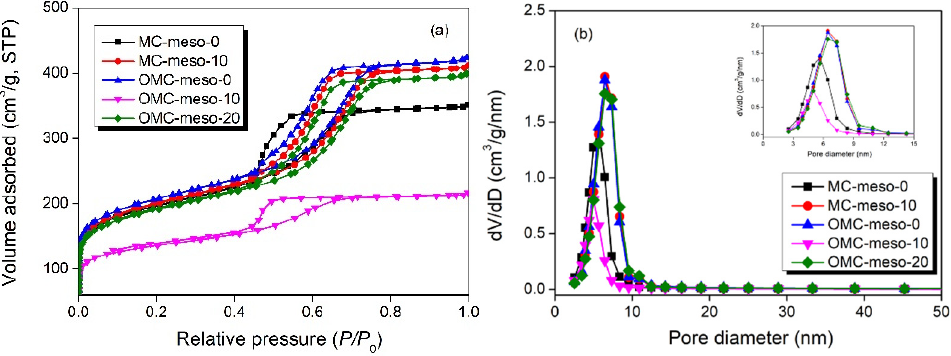
Figure 4. TEM images of MCs and OMCs prepared with different amounts of mesophase pitch.